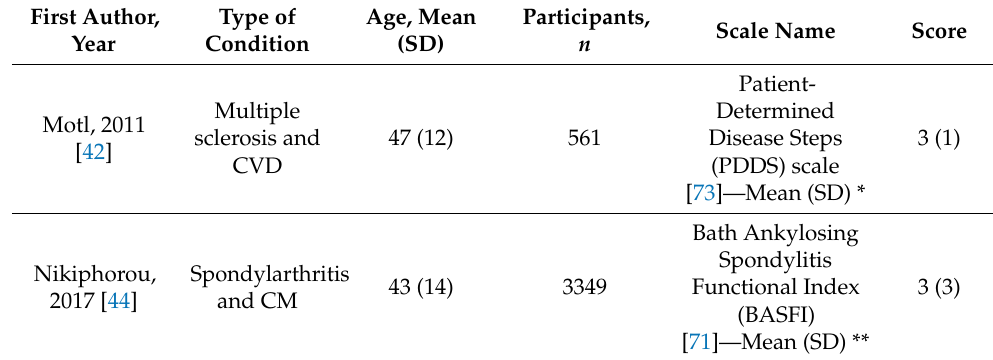
Table 4. Condition-specific physical